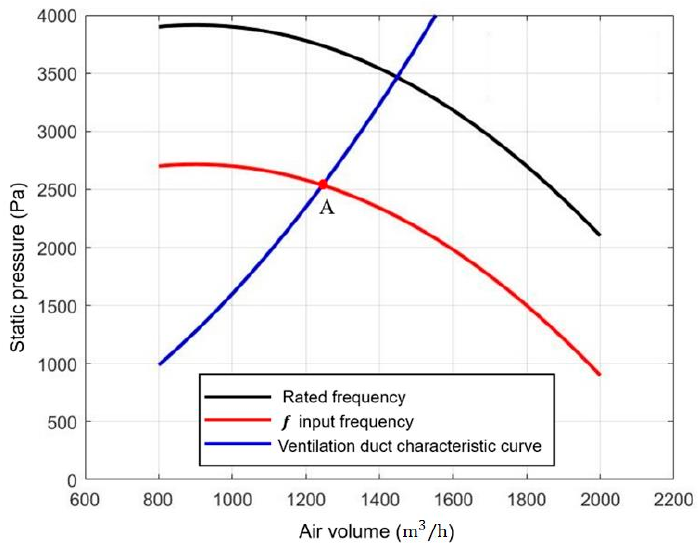
Figure 5. The general flow characteristic curve of the fan.